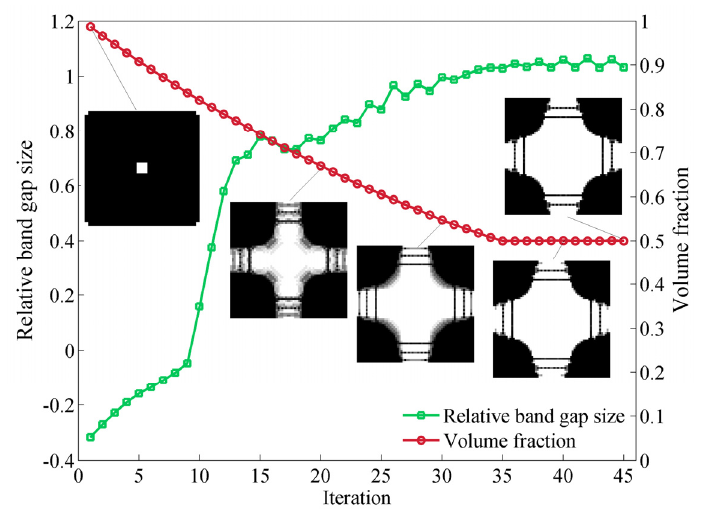
Figure 6. Evolution histories of the relative band gap size, volume fraction and topology in the optimization process with bulk modulus constraint β κ = 0.3.